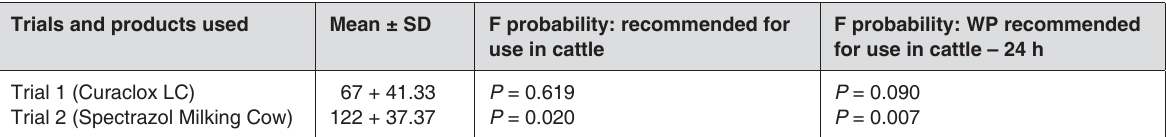
TABLE 1 Goats with clinical mastitis: Withdrawal periods (WP) of intramammary antibiotics compared to WP recommended for use in cattle with or without the 24 h safety margin (one sample t-tests) Trials and products used Mean ± SD F probability: recommended for F probability: WP recommended use in cattle for use in cattle – 24 h